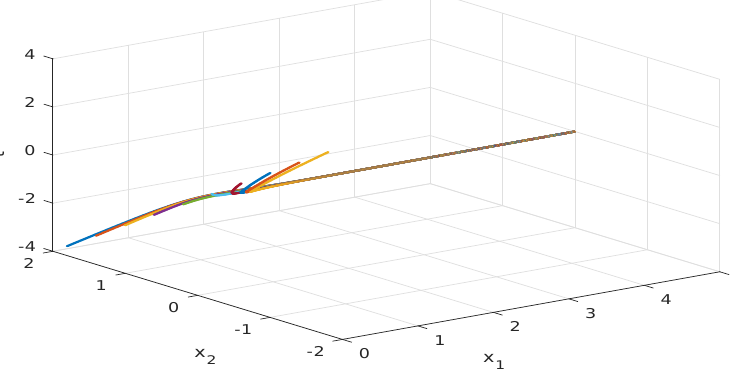
Figure 7. An illustration of the time responses between the real subspace pertaining to the model in (20), in which ˜ u ( t ) = 0 in Example 1.